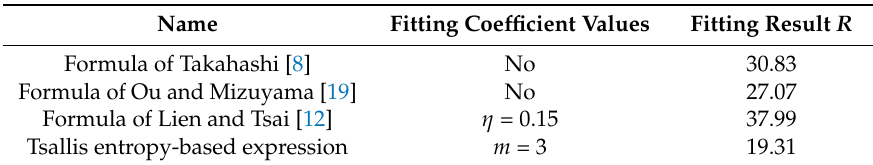
Table 2. Fitting results of the formulae of Takahashi [8], Ou and Mizuyama [19], and Lien and Tsai [12] and the Tsallis entropy-based expression with observed data of sediment concentration in debris flow from Takahashi